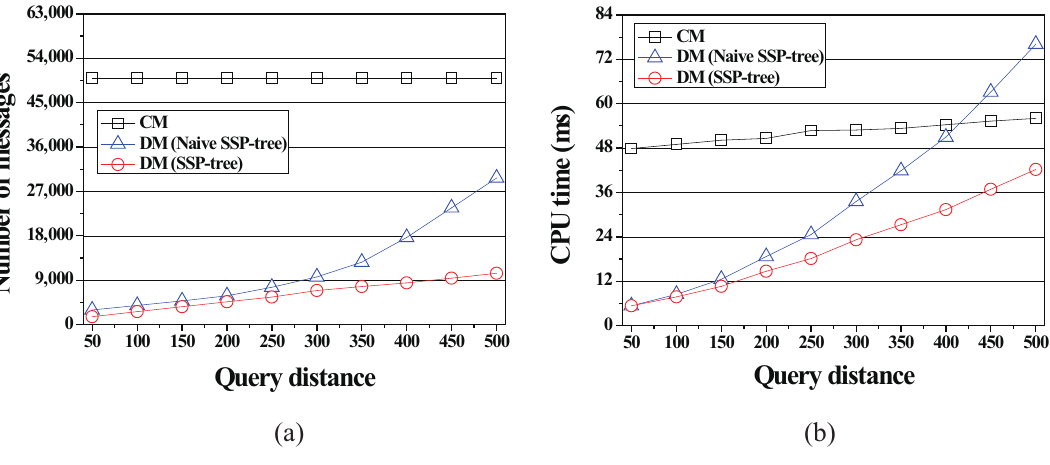
Figure 8. Effect of the query distance on the communication cost and the server computation cost. ( a ) Total number of messages vs. the query distance; ( b ) The amount of CPU-time vs. the query distance.